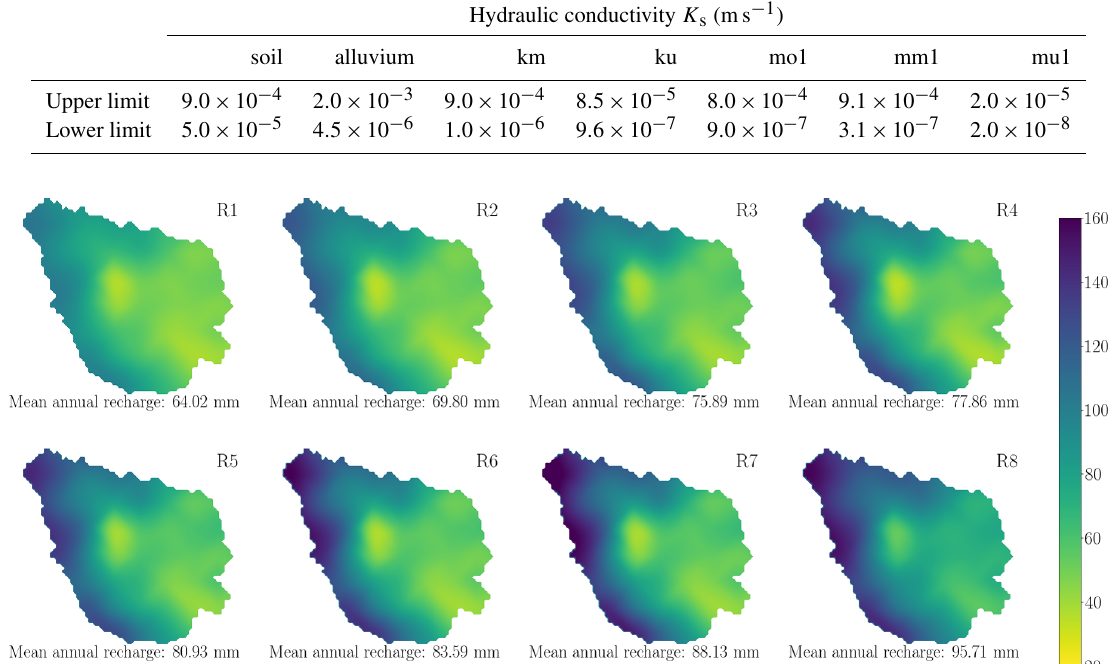
Figure 2. Recharge realizations used in this study (unit: mm). They were sampled from a high-resolution dataset of land surface fluxes for Germany (Zink et al., 2017).